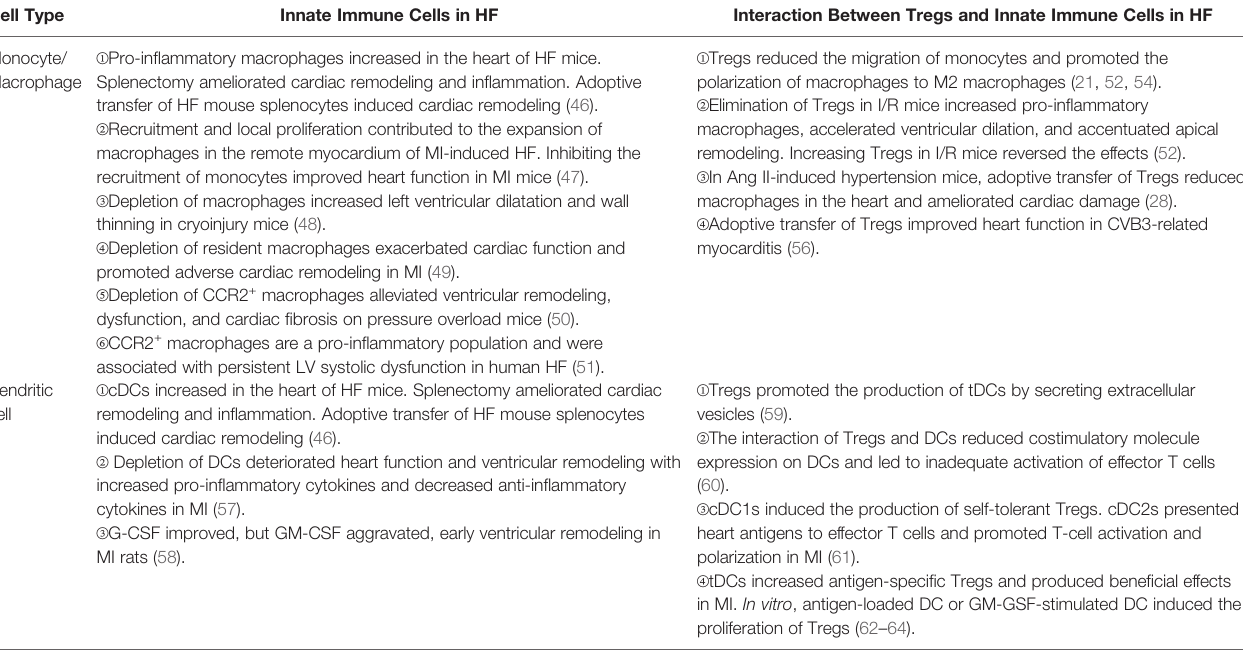
TABLE 1 | The interaction between tregs and innate immune cells in HF. Cell Type Innate Immune Cells in HF Interaction Between Tregs and Innate Immune Cells in